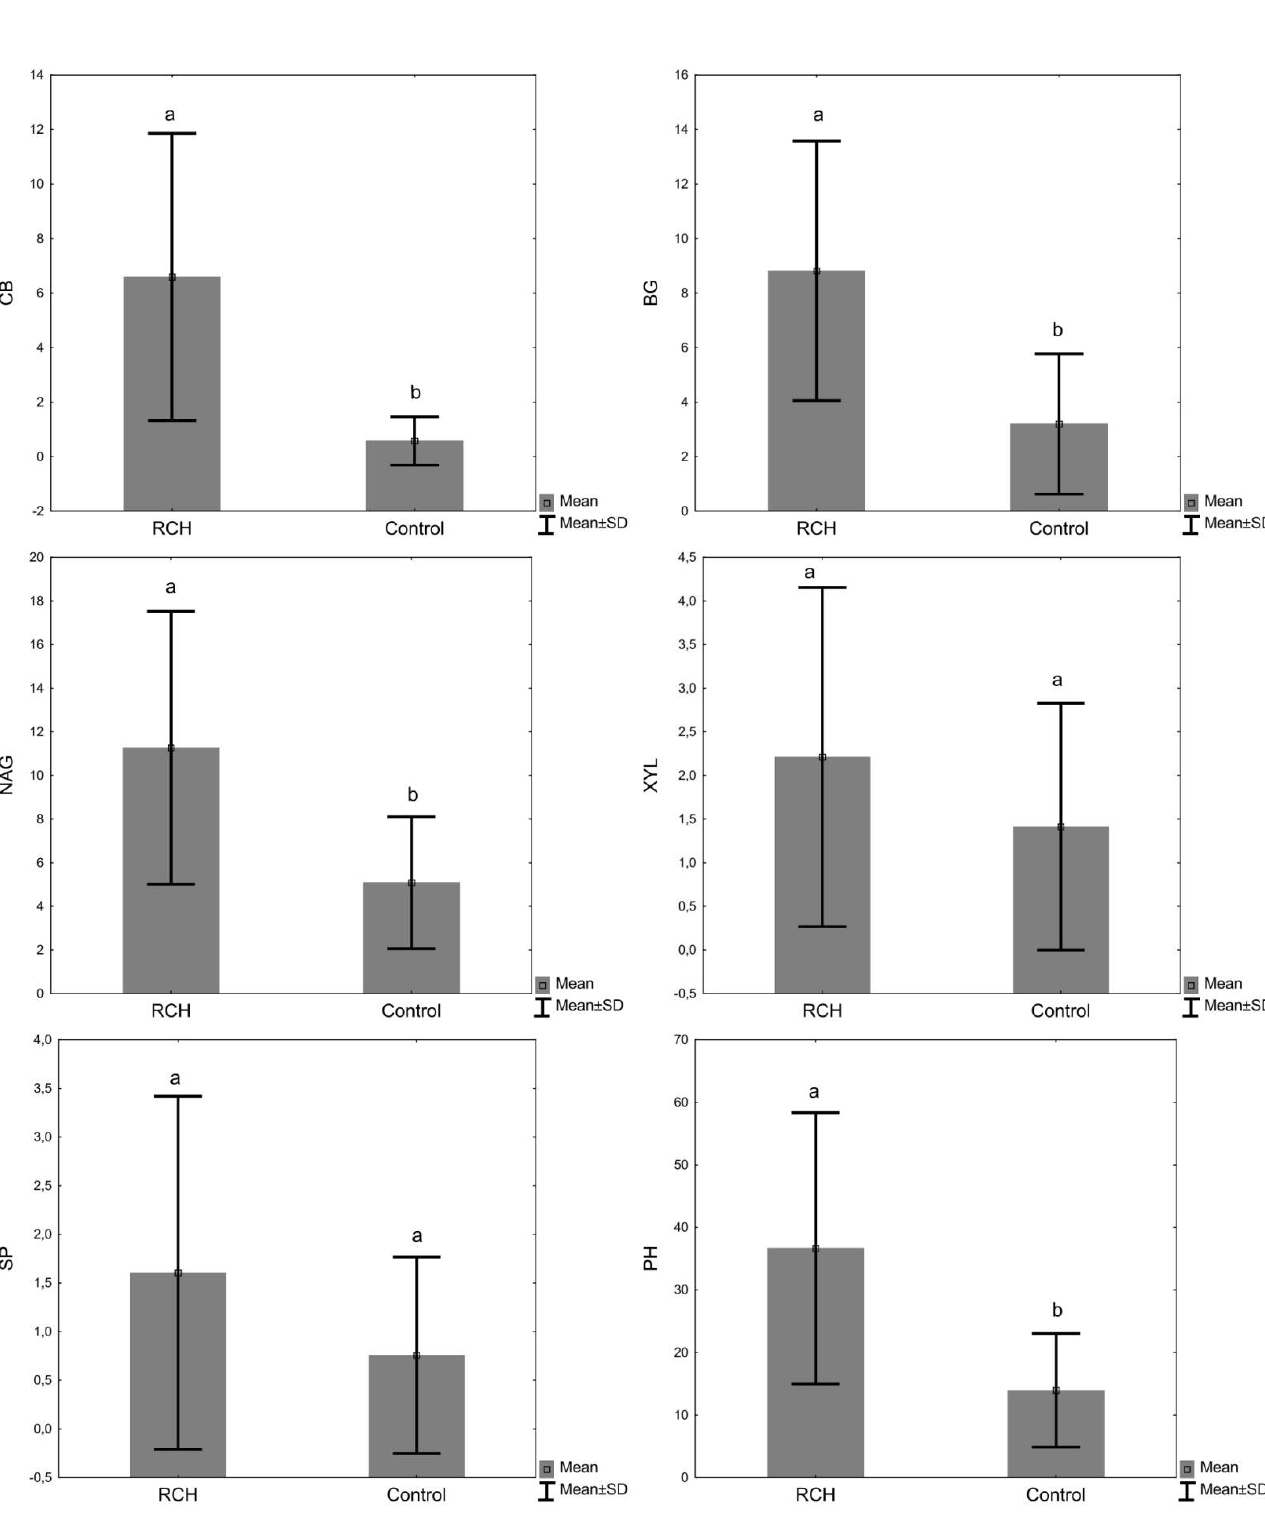
Figure 4. Enzymatic activity [nM MUB . g d.m. h −1 ] of soil from charcoal hearth horizon (RCH) and control soil; CB-β-D-cellobiosidase, XYL–β-xylosidase, NAG-N-acetyl-β-D-glucosaminidase, BG-β-glucosidase, PH-phosphatase and SP–arylosulphatase; letters (a, b)–significant differences between variants of study plots.